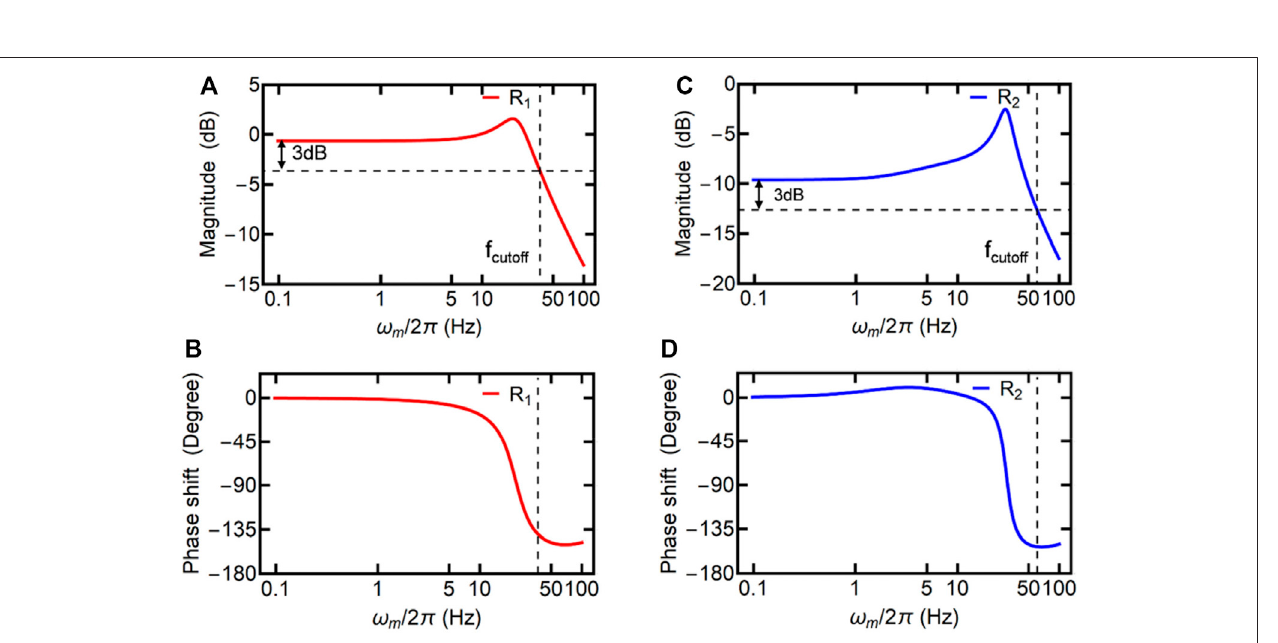
− 105 ° , and − 145 ° , respectively. In addition, the amplitude is red and blue curves represent the signals measured on membranes 1 and 2, respectively. As one can see in Figure 4 , reduced at a relatively high ω m . It is worth mentioning that the modulation frequency ω m is what we are interested in rather the shift lag between two mechanical resonators becomes larger as – D are − 0.5 ° , − 55 ° , ω than ω 0 , which is the carrier frequency. m increases. The phase shift in Figures 4A